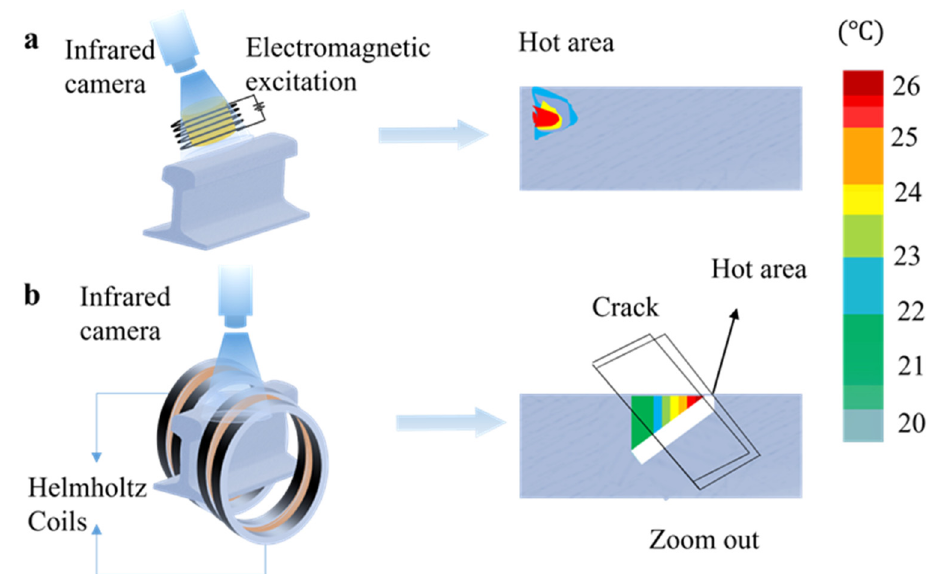
Figure 5. ( a ) Electromagnetic excitation. ( b ) Helmholtz coil excitation. Table 5. Comparison of thermal imaging testing